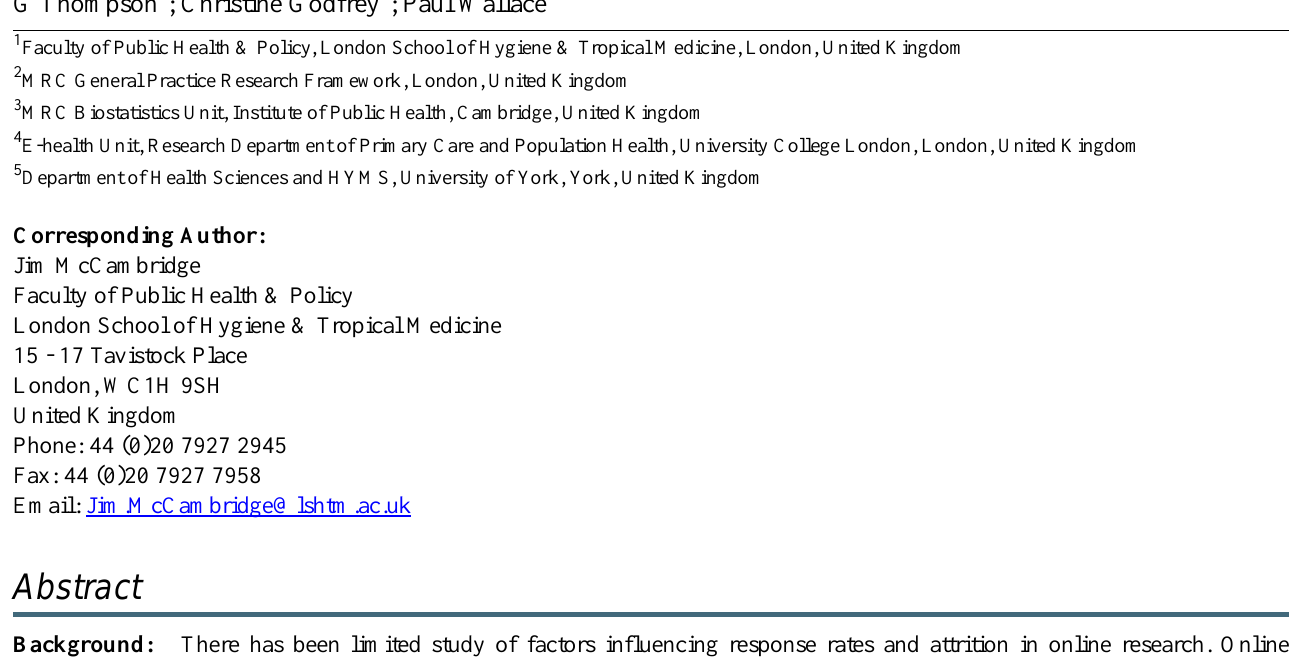
Attrition; retention; missing data; response rates; alcohol;